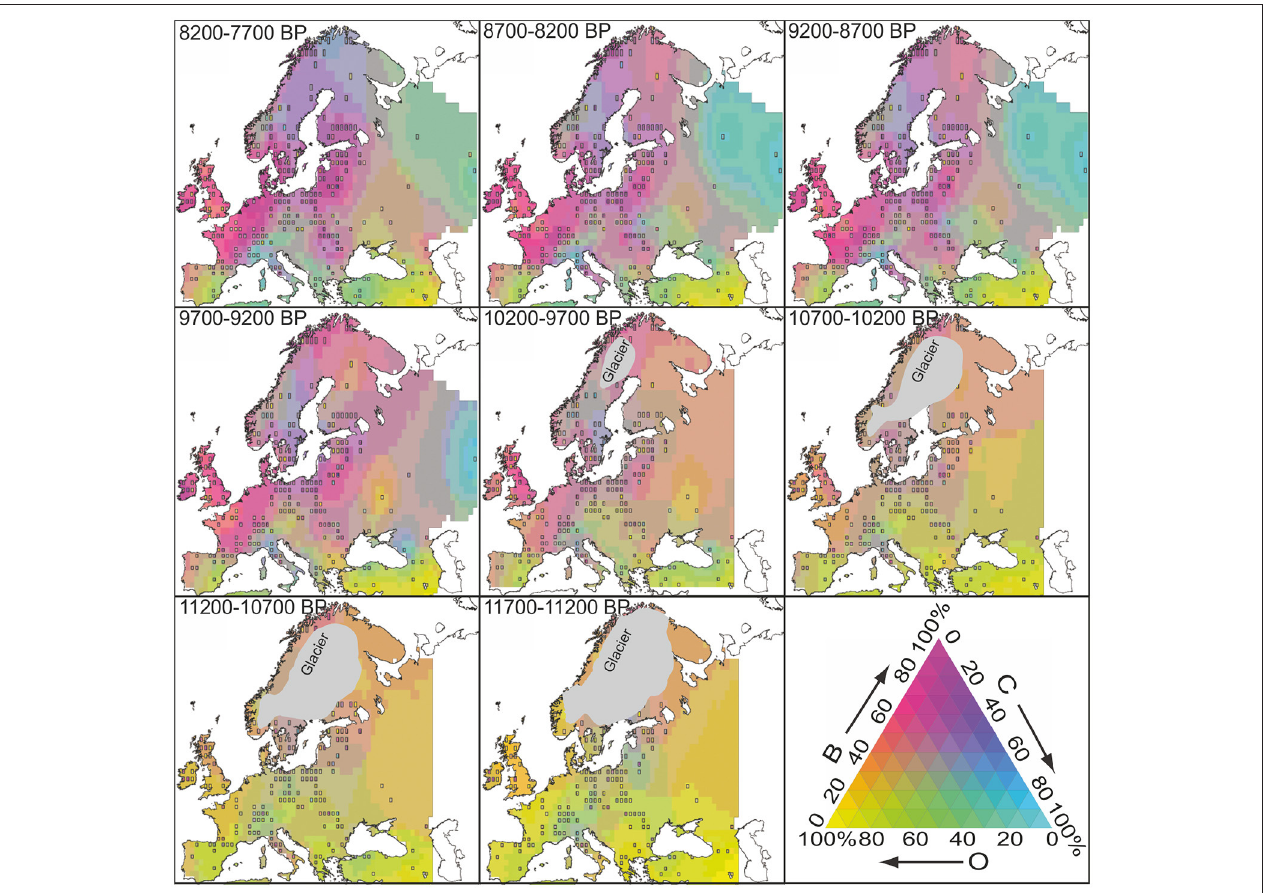
FIGURE 4 | Composite maps of the reconstructed land cover for eight time-windows (11700–7700 BP). The gray area marks the extent of the continental glacier according to Stroeven et al. (2016). The location of REVEALS estimates is marked by squares. The color-key for land-cover composition (C, coniferous forest; B, broad-leaved forest; O, open land) is presented as a triangular color